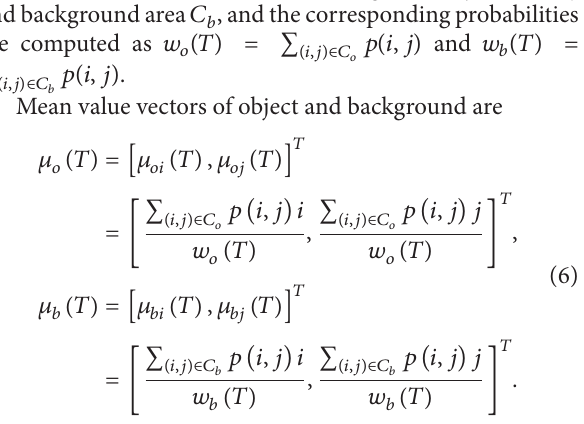
pixel (𝑚, 𝑛) , its corresponding binarized value 𝑏(𝑚, 𝑛) in